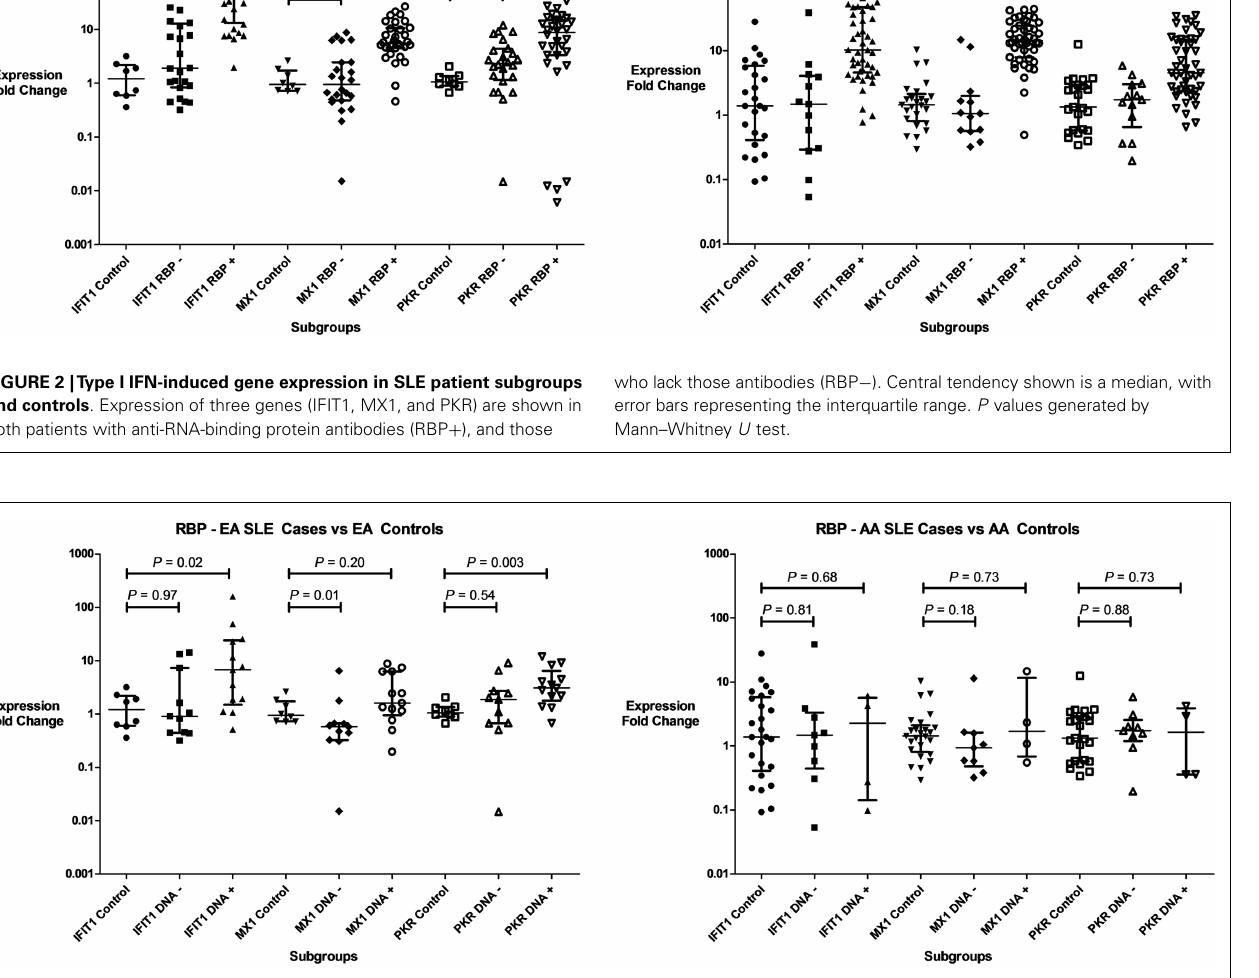
FIGURE 3 |Type I IFN-induced gene expression in RBP − SLE patient subgroups and controls in regards to of anti-dsDNA antibodies . Expression of three genes (IFIT1, MX1, and PKR) are shown in both patients